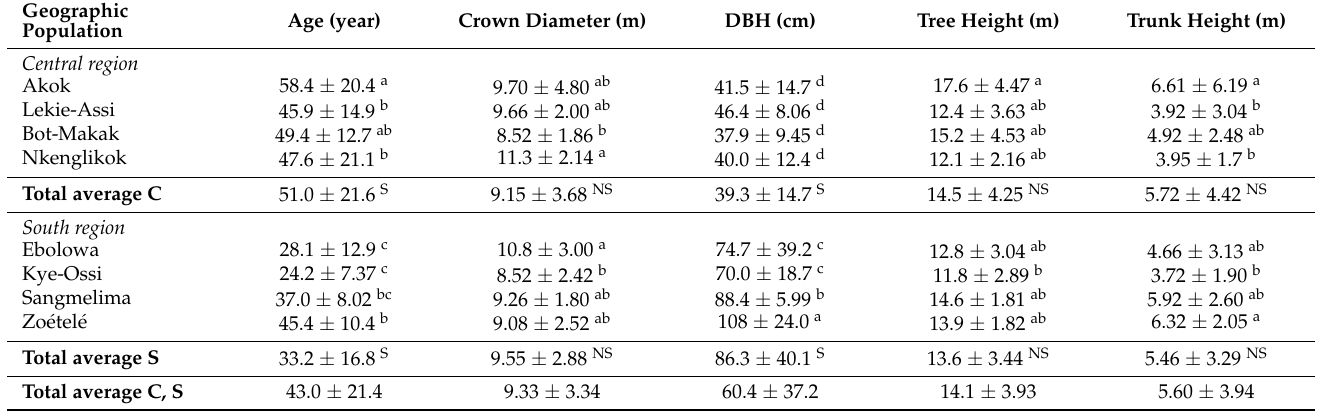
Means in each population marked with the same letter are not significantly different; S = significant difference, NS = no significant difference; the level of significance: α =